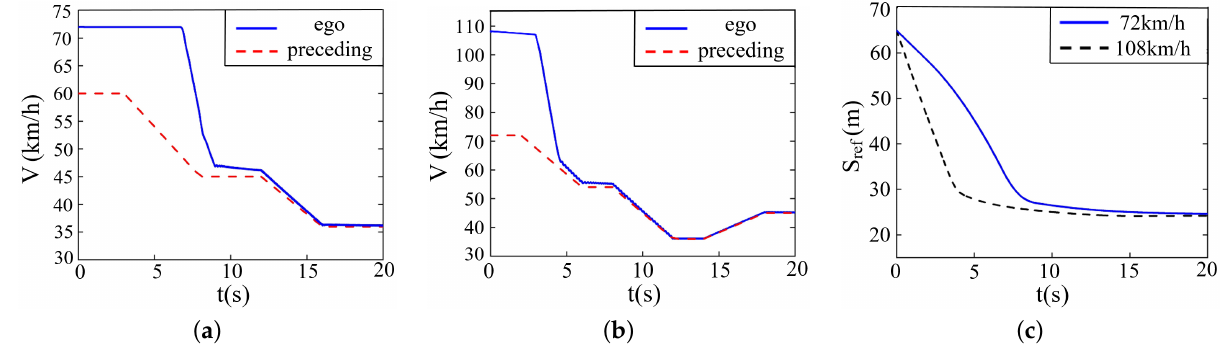
Figure 13. Simulation on straight roads when preceding vehicle drives at various speeds. ( a ) Velocity (72 km/h). ( b ) Velocity (108 km/h). ( c ) Relative